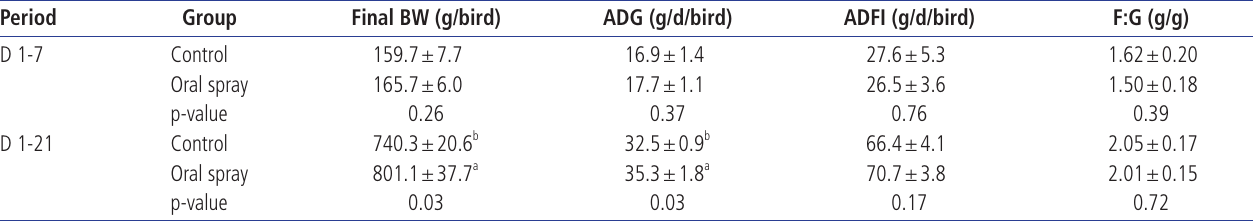
Data was expressed as mean±standard deviation (n = 4). BW, body weight; ADG, average daily gain; ADFI, average daily feed intake; F:G, feed:gain ratio. a,b Means within the same column lacking a common superscript differ (p<0.05).